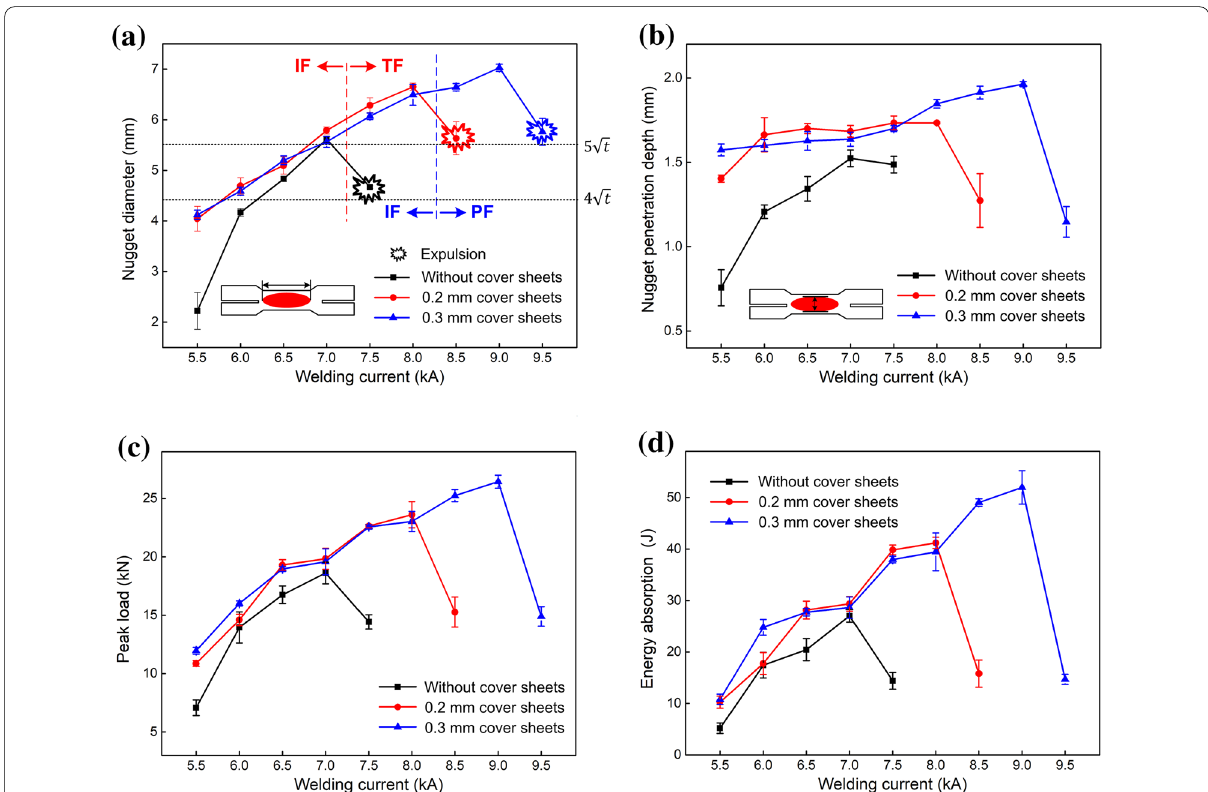
Figure 4 Line graphs of ( a ) nugget diameter, ( b ) nugget penetration depth, ( c ) tensile shear strength and ( d ) energy absorption as a function of welding current for different joint